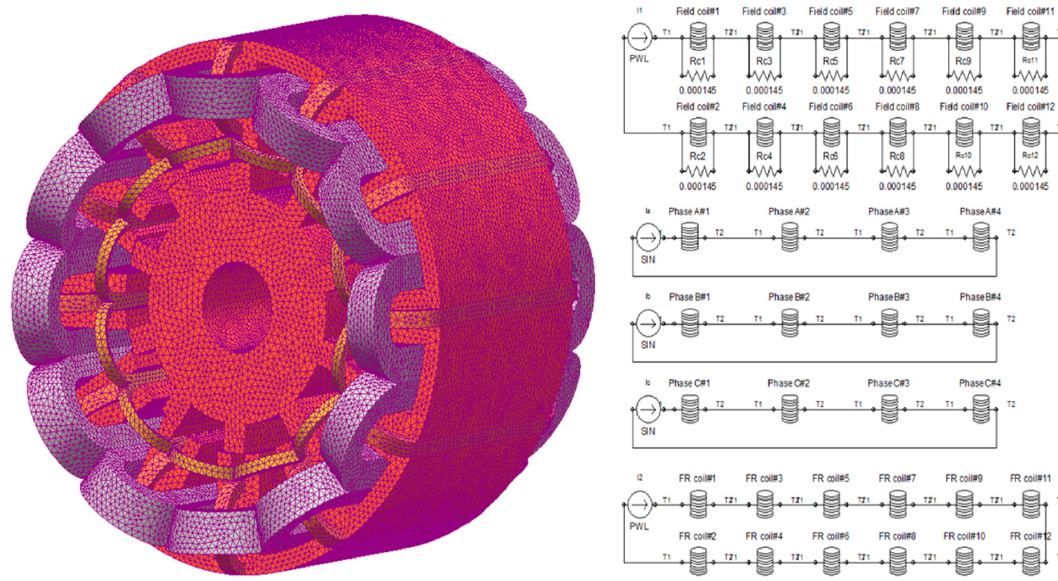
Figure 10. Field-circuit coupled finite element method (FEM) model of the designed NI HTS FSM.